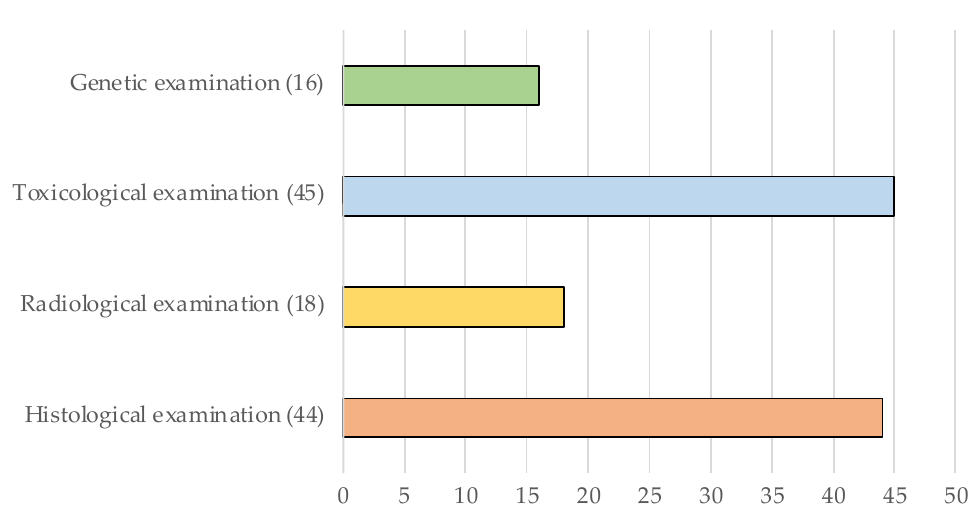
Figure 4. The graph shows the number of analyses conducted by exam type.